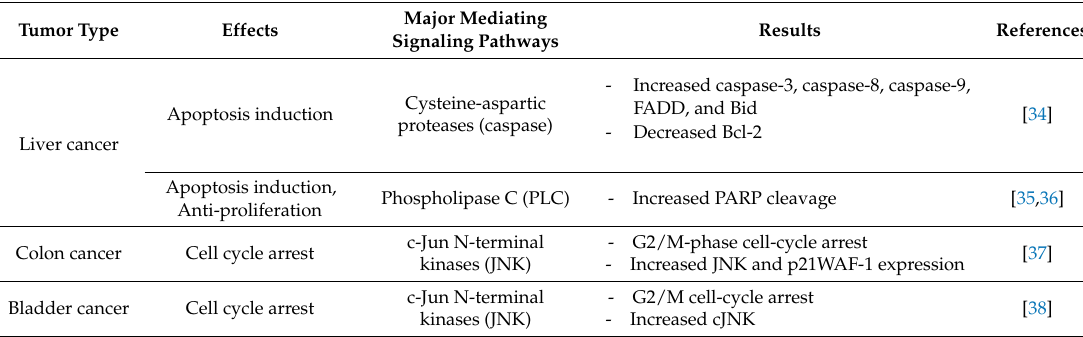
Table 1. Current evidence for the effects of cordycepin on various tumor types and possible